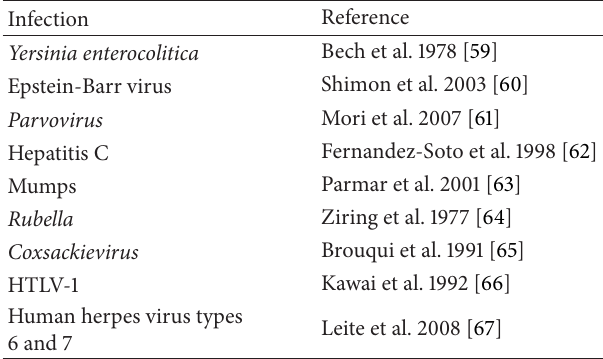
Table 2: Infectious agents associated with thyroid